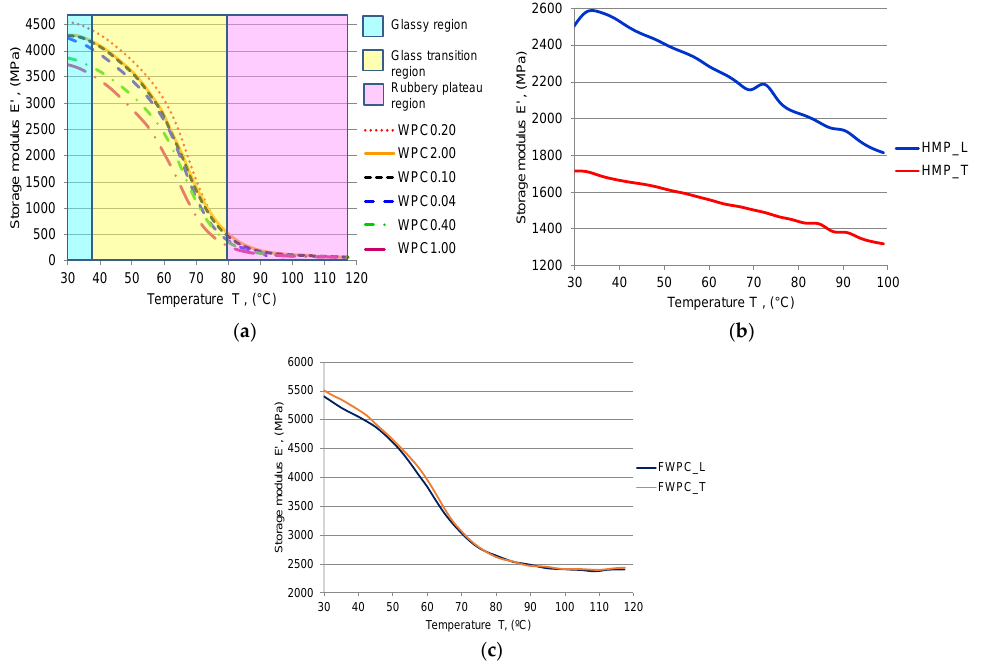
Figure 12. Variation of the storage modulus E’ with temperature: ( a ) WPC samples; ( b ) HMP samples; ( c ) FWCP samples.